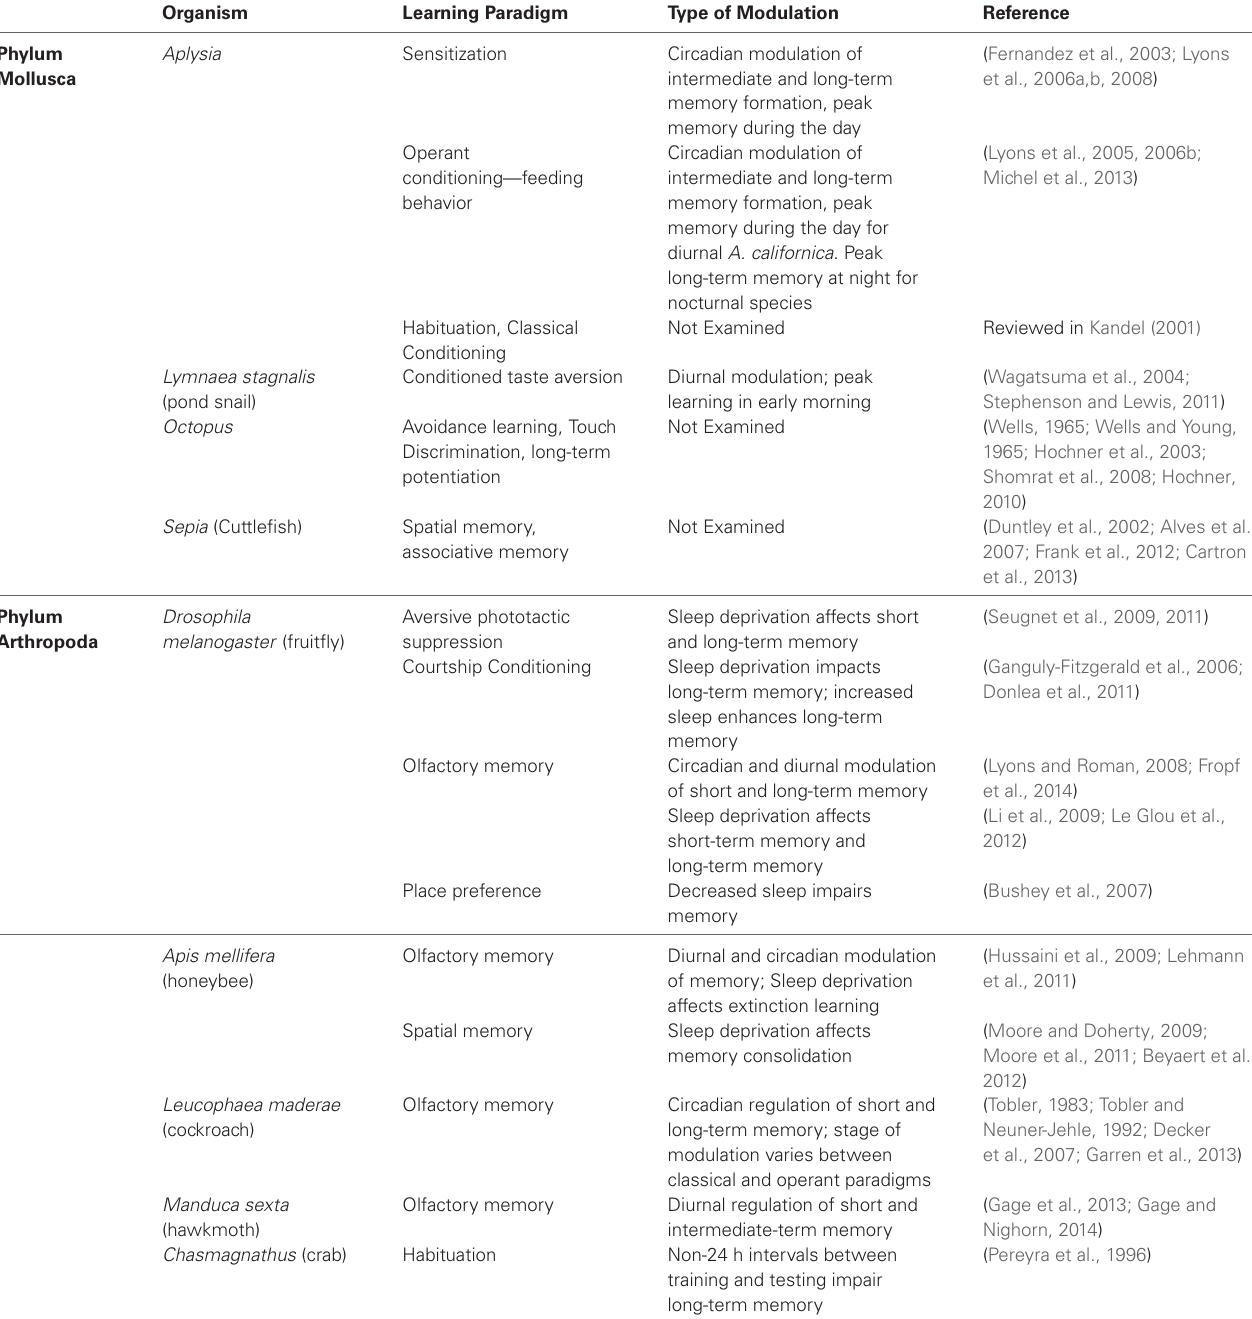
Table 2 | Examples of species frequently used for learning and memory studies in which sleep or circadian modulation of memory has also been examined